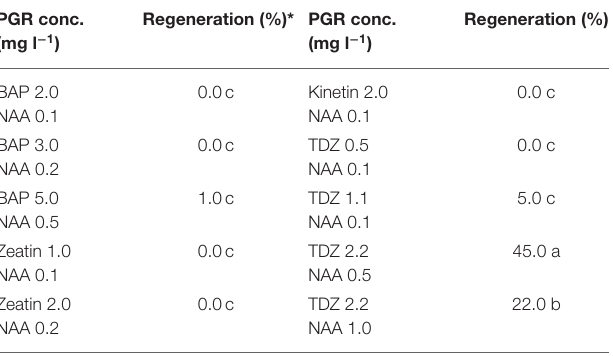
TABLE 4 | Effect of PGRs in shoot regeneration medium (SRM) on protoplast regeneration of rapeseed. PGR conc. (mg l − 1 )